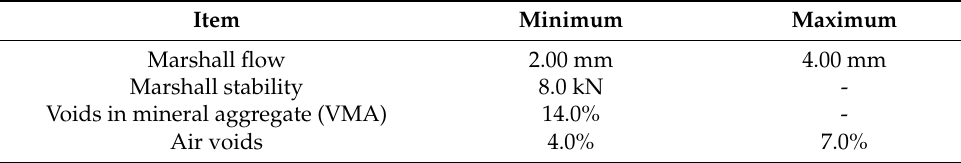
Table 4. Marshal test accepted limits for 14 mm DG asphalt (MRWA [14]).